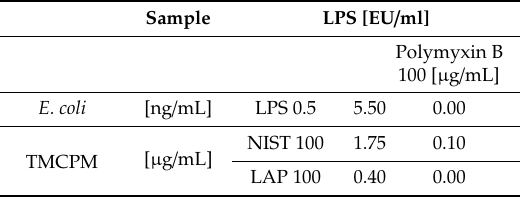
Table 1. Endotoxin concentration (EU / mL) in TMCPM (NIST and LAP) preparations with or without polymyxin B